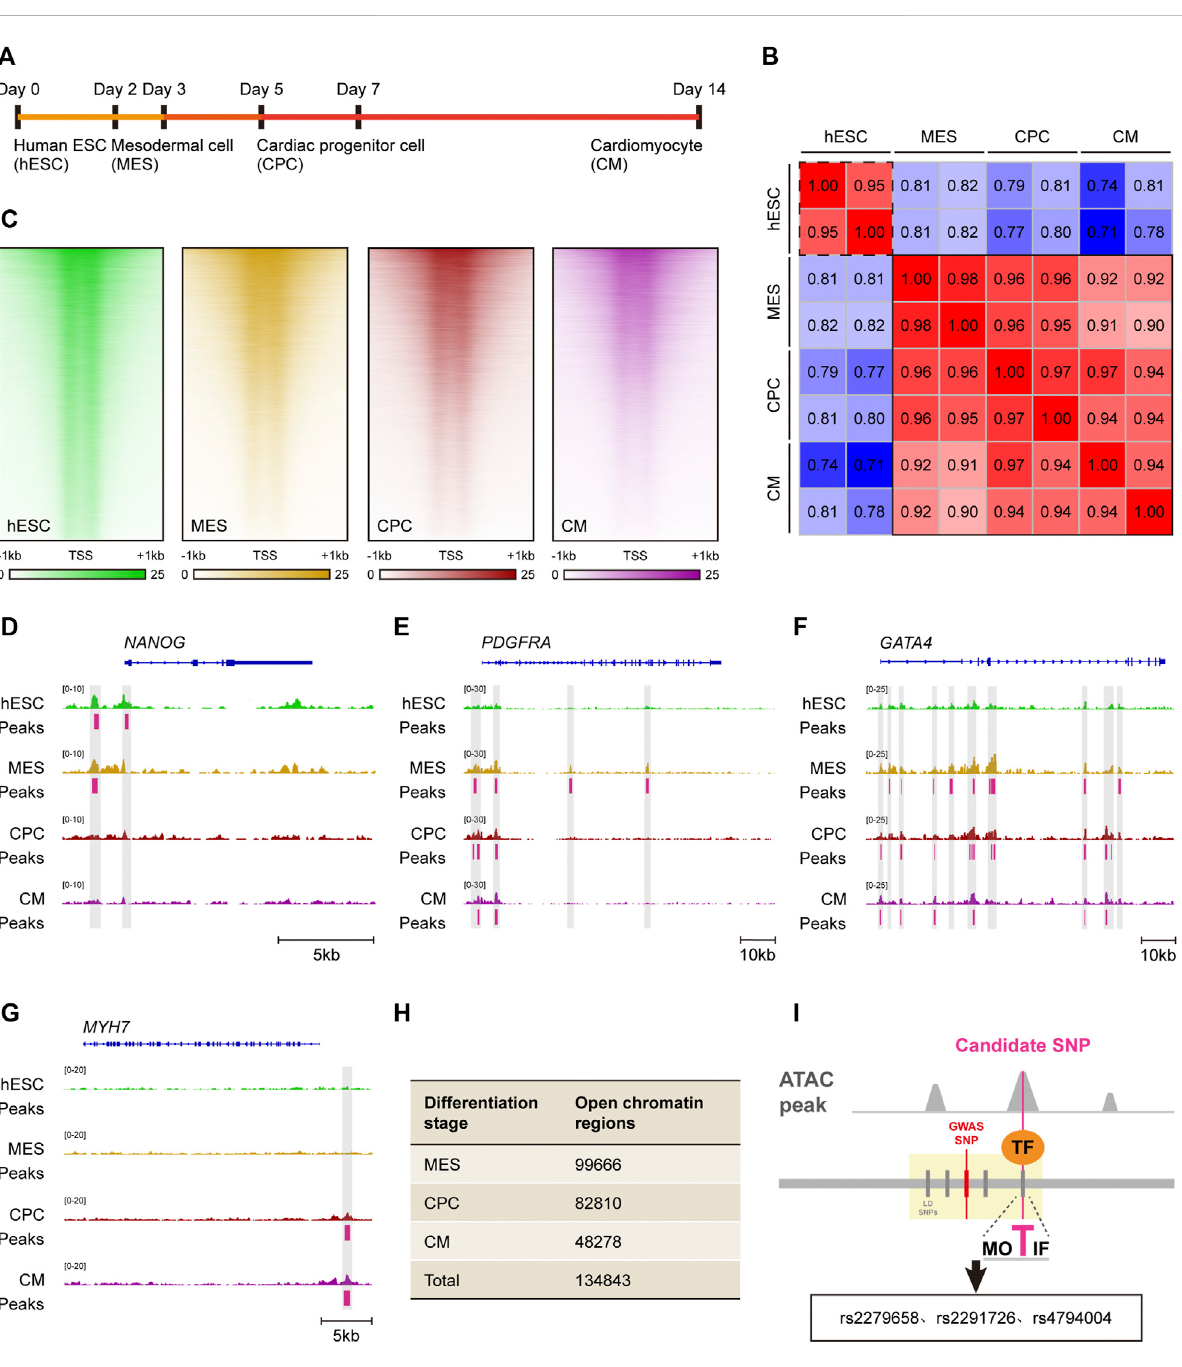
FIGURE 3 Identi fi cationofcandidate cis -regulatorySNPsbasedon invitro cardiacdifferentiationmodel. (A) Schematicof invitro cardiacdifferentiationof hESCs. (B) CorrelationheatmapofATAC-seqaccessibilityinhESC,MES,CPCandCM.Sampleswithsimilarchromatinaccessibilityarehighlightedby black solid or dashed border. (C) Read density heatmaps showing ATAC-seq signal enrichment at 41,029 genomic regions in hESC, MES, CPC, and CM.Eachsignalisrepresentedasahorizontalline,comparedina2 kbsummit-centeredwindow,andrankedverticallybysignalstrength. (D – G) IGVviewsofthe NANOG (D) , PDGFRA (E) , GATA4 (F) and MYH7 (G) locus.ATAC-seqpeaksactivatedinhESC,MES,CPCorCMarehighlightedingray. (H) NumberofopenchromatinregionsinMES,CPCandCMaswellastotalopenchromatinregionsduringtheentirecardiacdifferentiationprocess. (I) Visual illustration of the analytical pipeline. Candidate cis -regulatory SNPs are recognized among causal non-coding SNPs by overlapping with ATAC-seq